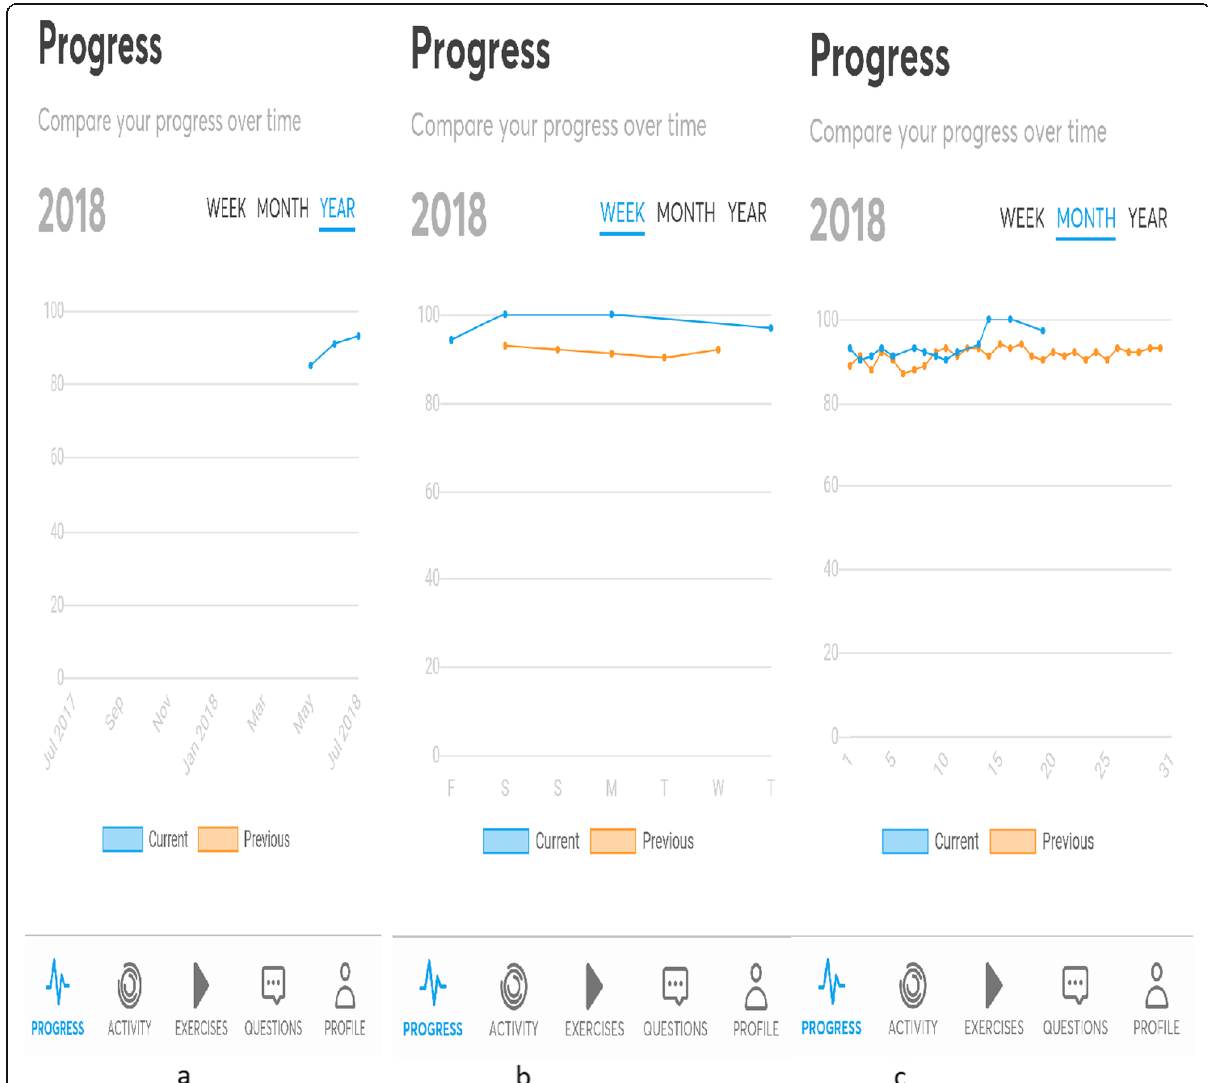
Fig. 2 a – c Evolution of the performing of the exercises during the week with proper information to the patient with the degree of